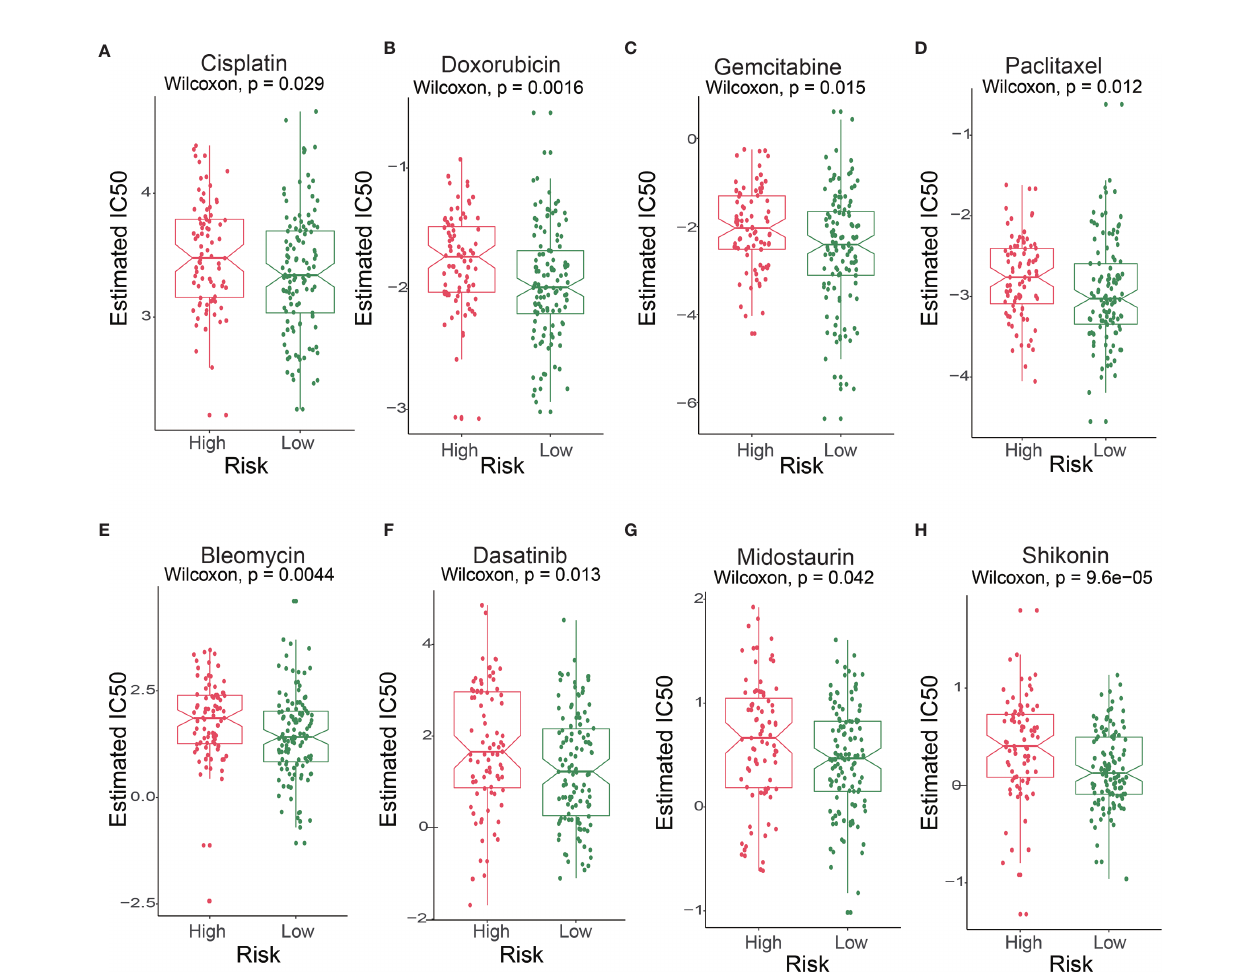
FIGURE 7 | The IC50s of chemotherapeutic agents with 6-lncRNA signature. (A) cisplatin, (B) doxorubicin, (C) gemcitabine, (D) paclitaxel, (E) bleomycin, (F) dasatinib, (G) midostaurin, (H)